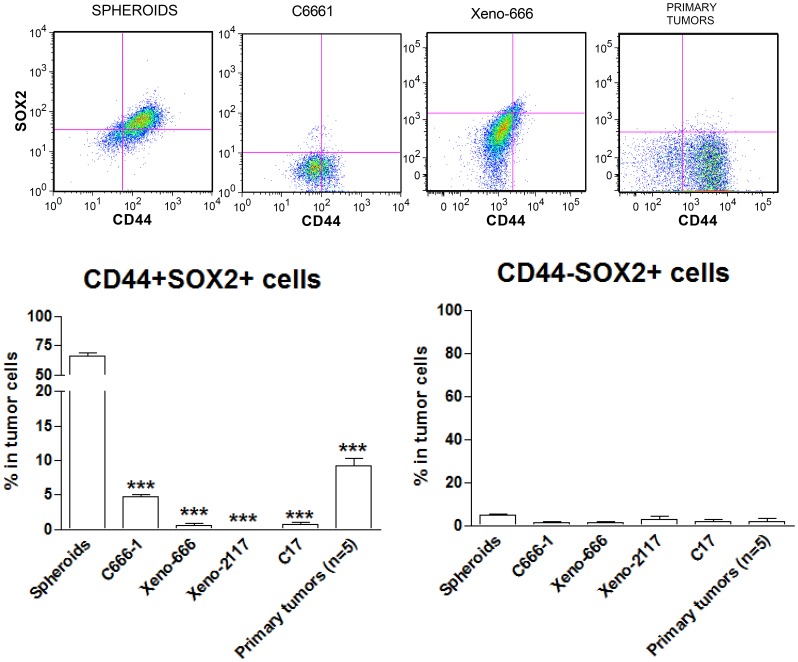
CD44 and SOX2 as CSC markers.By flow cytometry, SOX2 was found to be preferentially expressed on CD44+ cells and coincidentally, SOX2 expression was rarely detected in CD44− cells. Cells coexpressing both CD44 and SOX2 were found to be enriched in spheroids. Histograms denoting mean ± SE (n≥3) with statistical significance calculated by t-test (*P<0.05, **P<0.01, ***P<0.001).